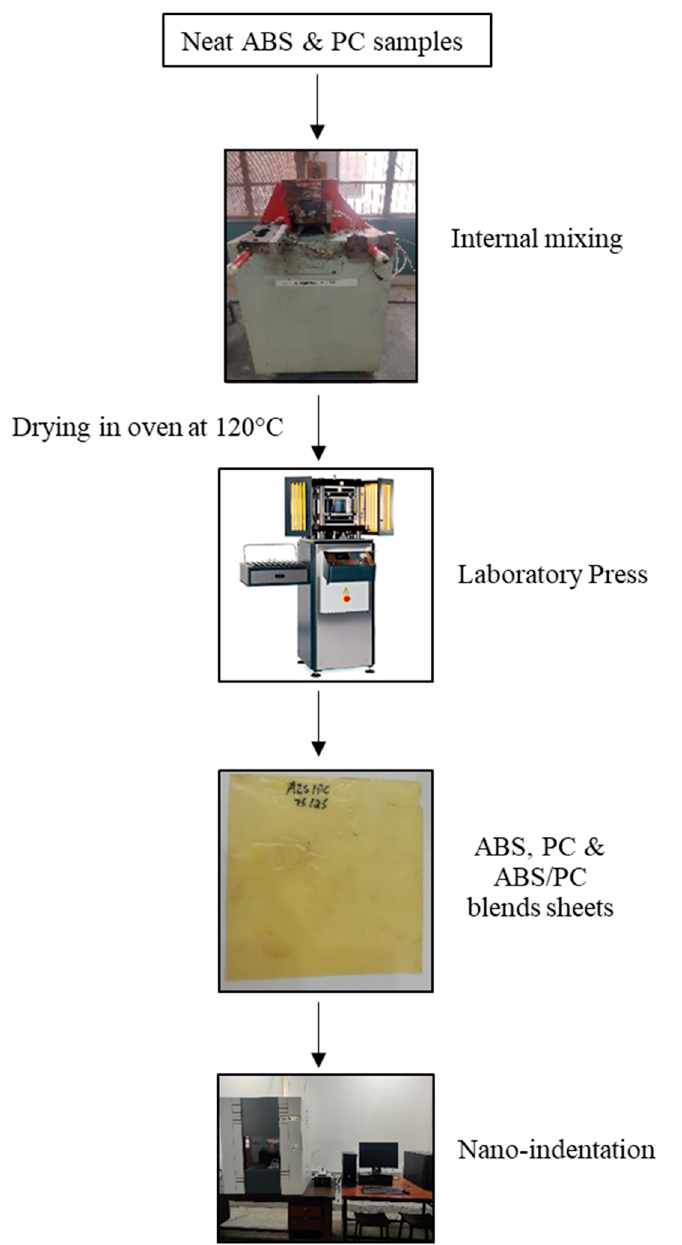
Figure 1. Schematic demonstration of the adopted